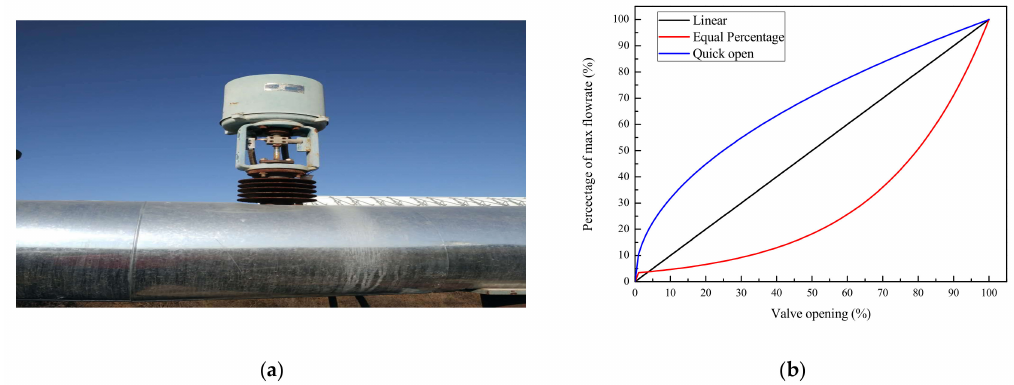
Figure 5. ( a ) View of the control valve; ( b ) three inherent flow characteristics of the control valve.